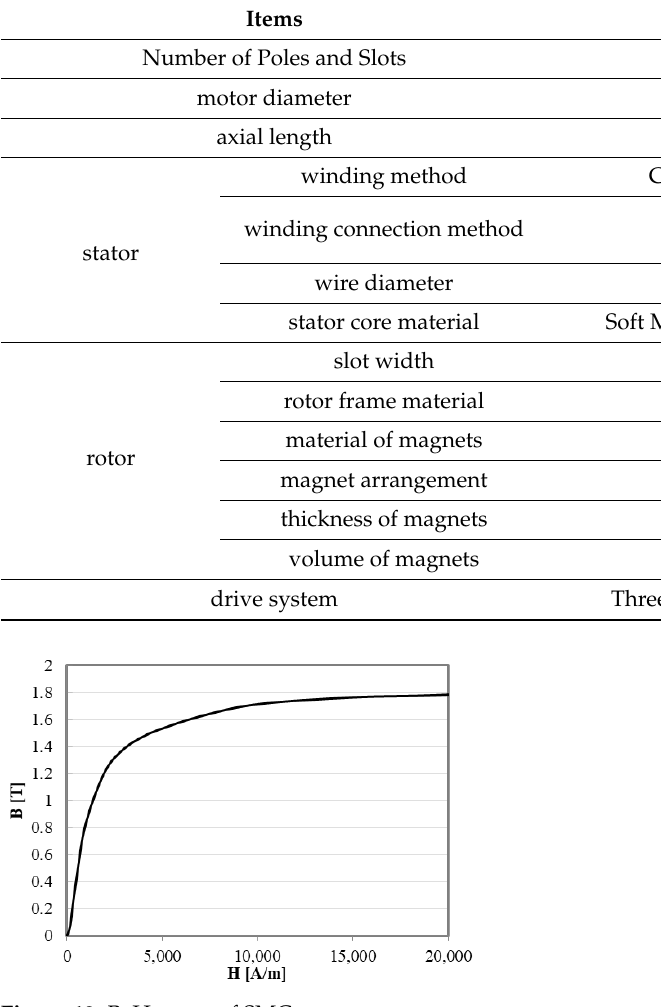
Figure 19. B–H curve of Figure 19. B – H curve of SMC.